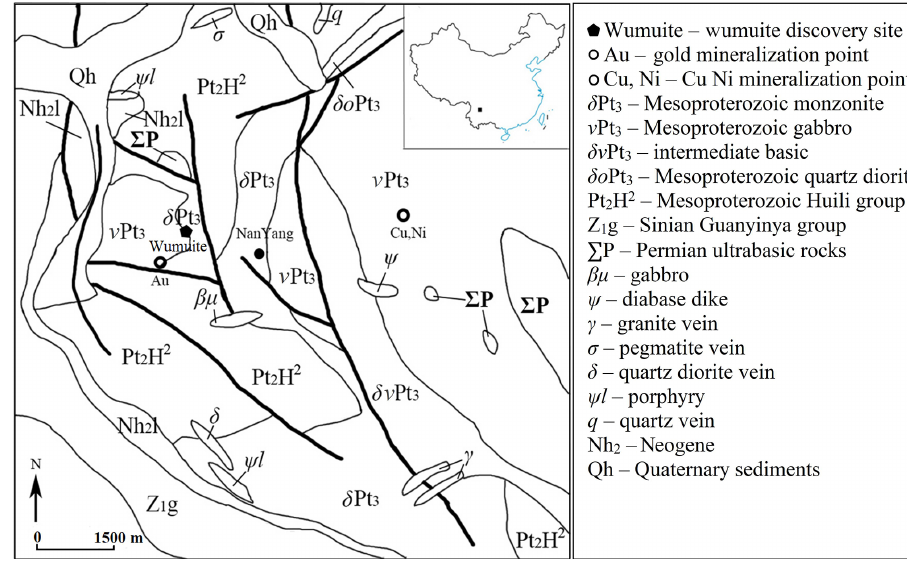
Figure 1. Geologic map of the type locality.